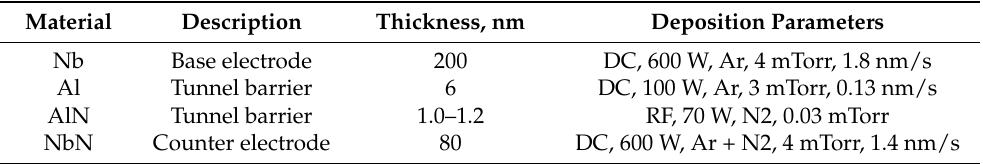
Table 1. Formation of the three-layer structure in a single vacuum cycle (Leybold L560UV).